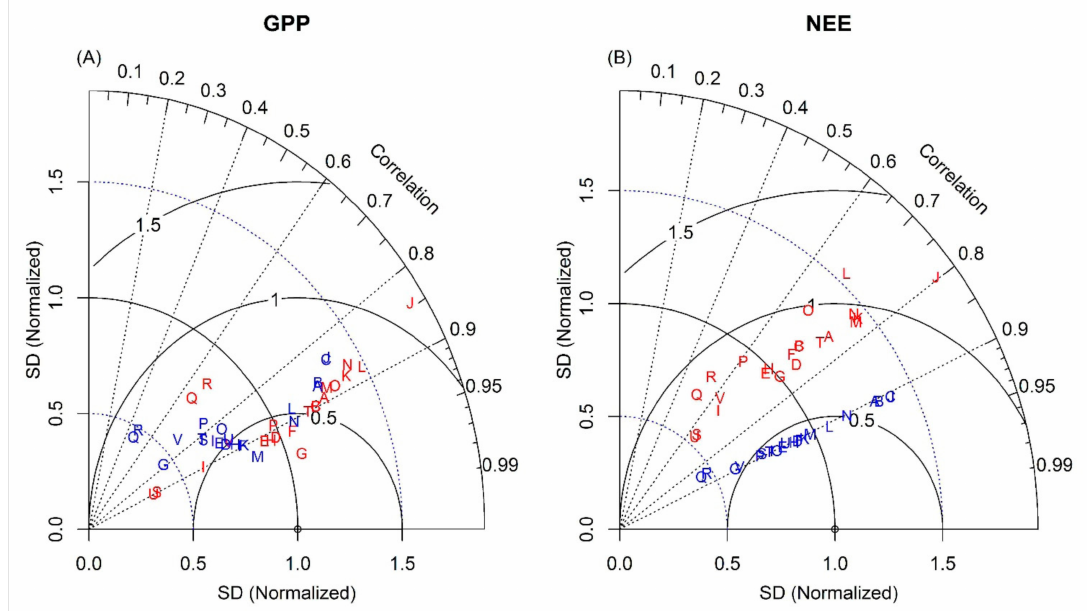
Figure 2. Taylor diagram of CO 2 fluxes simulations against eddy covariance observations. Uppercase letters represent the different simulations in the wet season (blue letters) and dry season (red letters) of 2014. The open circle located at normalized standard deviation = 1.0 and RMSE = 0 indicates the eddy covariance observations. Standard deviation was normalized using hourly data of CO 2 fluxes simulations and eddy covariance observations. Gross primary productivity (GPP; ( A )) and net ecosystem CO 2 exchange (NEE; ( B